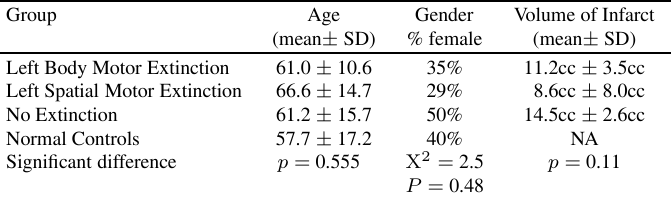
Table 1 Sex distribution, mean age and clicking rates in patients in each